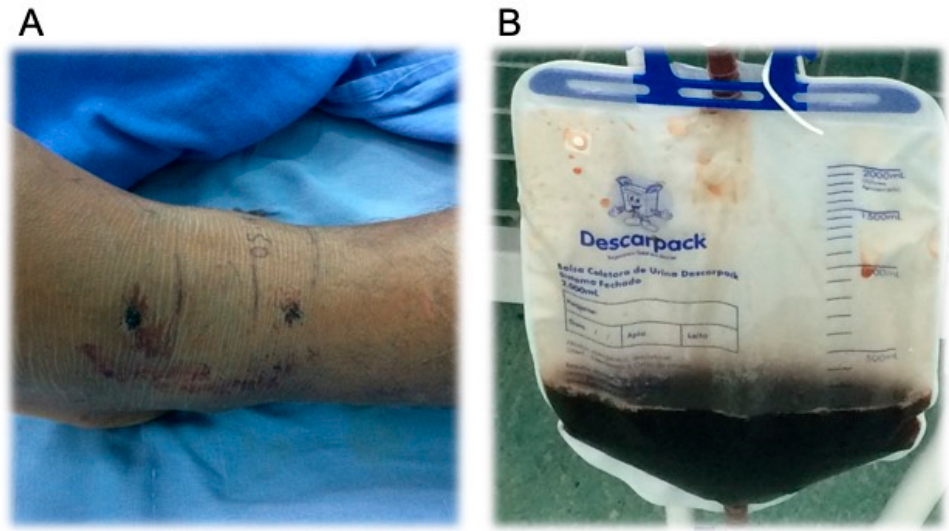
Figure 2. Patient signs following 10 h of snakebite. ( A ) Local examination showed two deep fang marks, swelling, and bleeding. ( B ) Urinary drainage bag showing macroscopic myoglobinuria, a black-colored urine. Table 1. Patient laboratory tests following rattlesnake